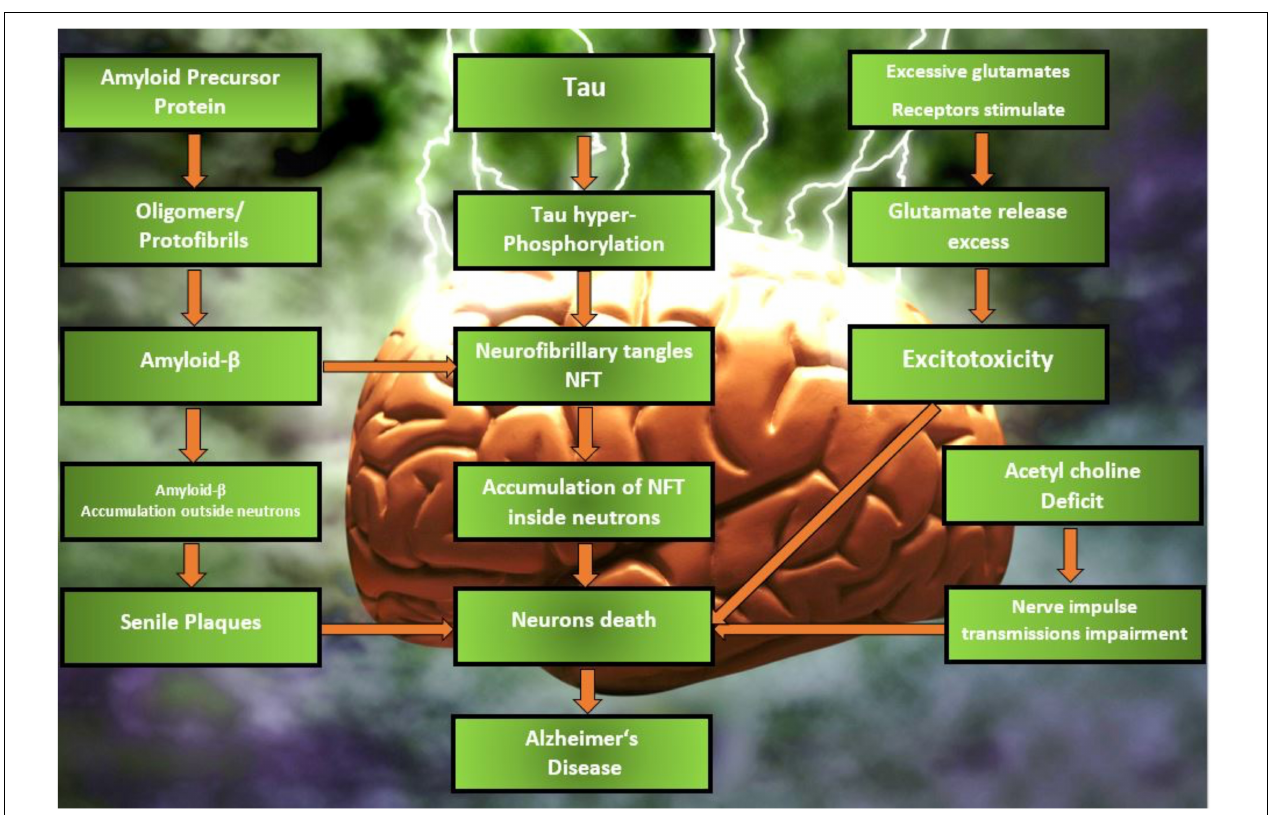
FIGURE 1 | Different phases of pathophysiology of